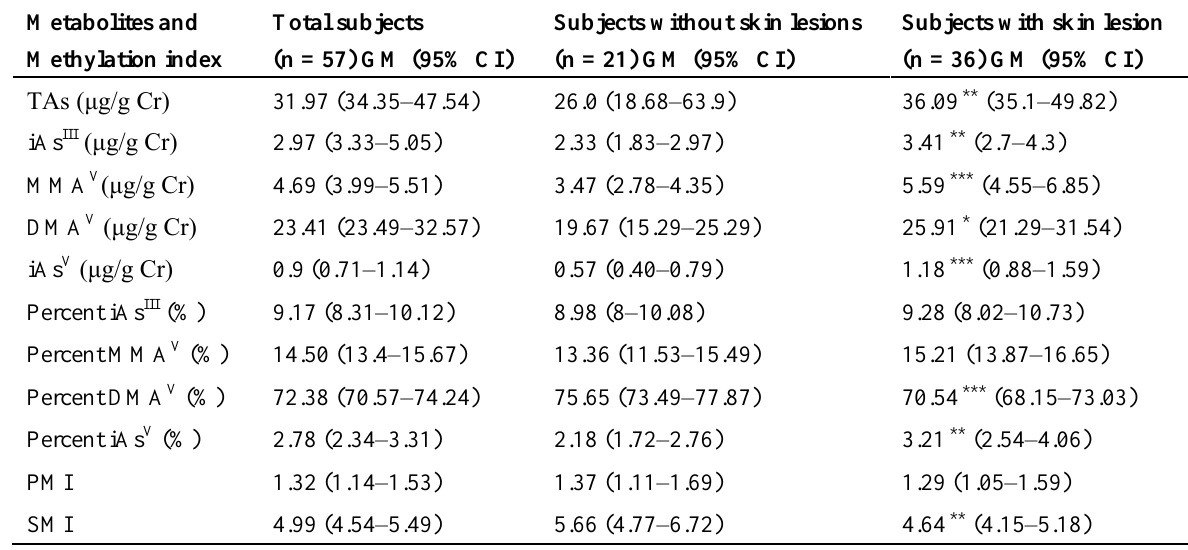
Table 2. Concentrations and percentages of arsenic species in urine of the volunteers (N = 57).